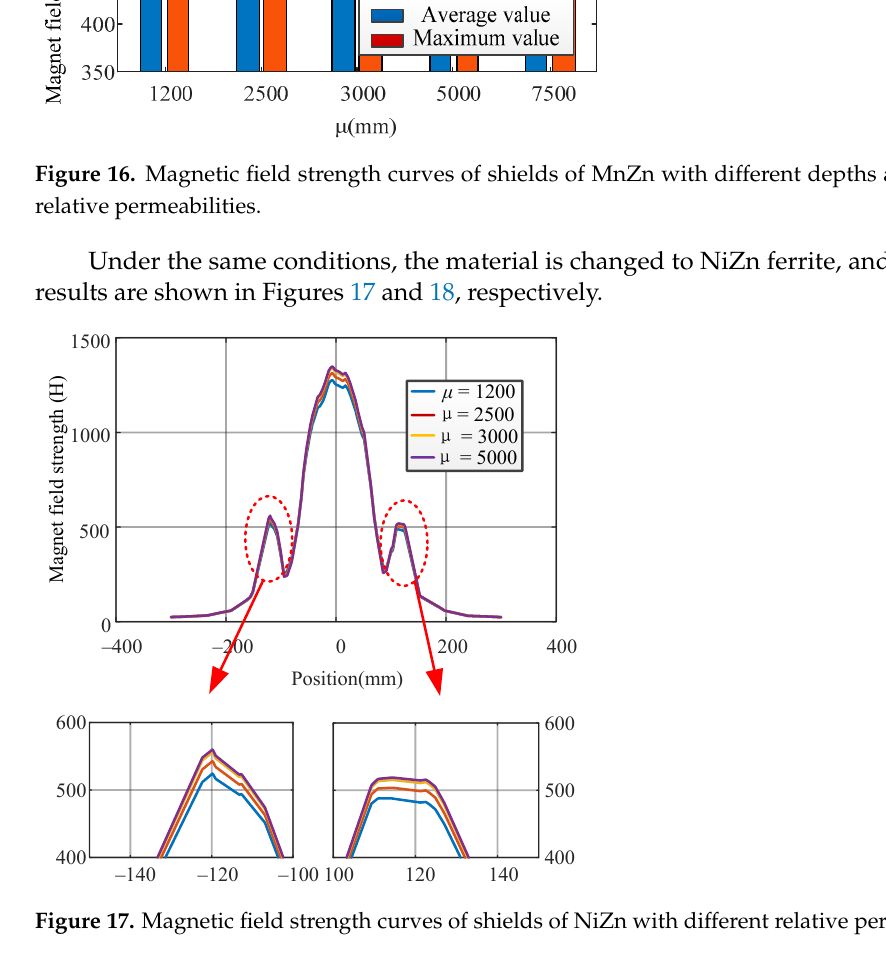
Figure 18. Magnetic field strength curves of shields of NiZn with different depths and different relative permeabilities. 3.3. Correlation Analyses and Linear Fitting The Pearson, Kendall and Spearman correlation analyses are used to obtain correla- tion coefficients for these selected variables, and the results are listed in Table 2. Ac- cording to the table, input power and relative permeability have significant influences on the fringe effect, and the influence of the radius is less than them. The influence of depth almost has no worth in statistical analysis because of the large significance value. Table 2. Correlation analysis results. Radius